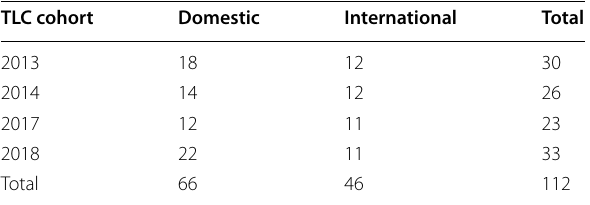
Table 1 Demographics of the transnational learning